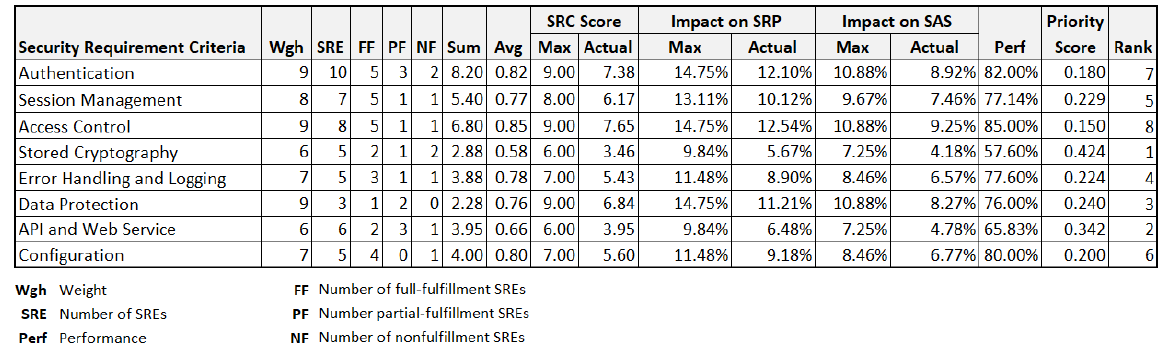
Figure 5. Security assurance scoreboard—vulnerability metrics. Figures 4 and 5 are two drill-down scoreboards providing the “next-level” details of security requirement metrics and vulnerability metrics. The two tables permit metrics to be monitored through the level of assurance criteria, which allows an effective and “tidy” collection of the stakeholders’ views of the areas of interest. In that table, rows identify the criteria, while the columns identify the areas of interest and the key assurance metrics. It is noted that, in Figure 4, the weight factors for all security requirement criteria are esti- mated by security and domain experts using a subjective weighting approach. As we can see, among the eight security requirement criteria, “Access Control” has the highest actual impact on security assurance score calculation (i.e., 9.25%) as well as the best performance (85%). On the other hand, “Stored Cryptography” is the worst assurance criterion since both the performance and the impact on SAS are the lowest (57.6% and 4.18%, respec- tively).